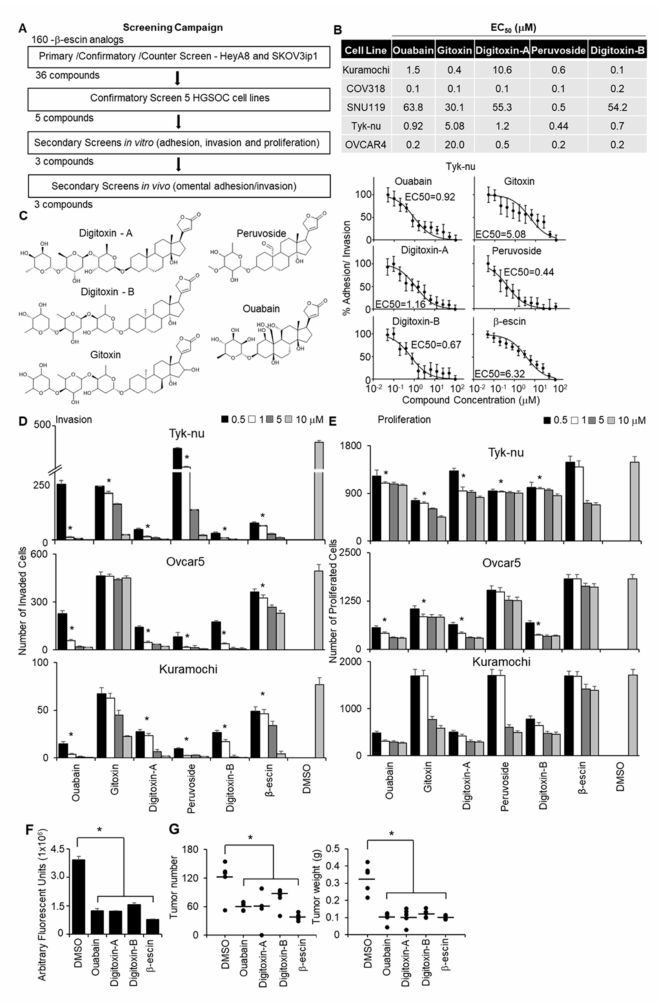
Figure 2. Quantitative high throughput screening with a 3D organotypic model to identify the compounds structurally similar to β -escin that inhibit OvCa metastasis. ( A ) An outline of the screening strategy and the number of active compounds after each assay are shown. ( B ) The half-maximal response values (EC 50 ) of each compound for their inhibitory effect on OvCa cell adhesion/invasion to the 3D organotypic model (16 h) are reported. Representative dose − response curves of Tyk-nu OvCa cell adhesion/invasion to the 3D organotypic model (16 h, mean ± standard deviation, n = 8). ( C ) Chemical structures of the active compounds. ( D , E ) In vivo secondary biological screens. Invasion and proliferation assays. The effect of β -escin sources at four doses were tested in three OvCa cell lines. ( D ) OvCa cancer invasion (24–48 h) was tested using a 96-well Boyden chamber lined with collagen type I as the ECM using the 3D organotypic culture. ( E ) OvCa cell proliferation (96 h) was tested in 384-well plates on the 3D organotypic culture. ( F , G ) In vivo biological screens. Adhesion/invasion and prevention metastasis assays were performed. The compounds were tested at a 5 µ mol/L dose or dimethyl sulfoxide (DMSO) solvent control (1 µ L) in cold phosphate-buffered saline (PBS; 500 µ L total). GFP-labeled ID8 p53-/- cells (5 million) were mixed with the indicated compound and injected into C57BL/6 mice. ( F ) In vivo adhesion/invasion assay. The mice were sacrificed at 16 h, and the fluorescence signal in the omentum was measured. ( G ) In vivo prevention metastasis assay. After the initial injection of cancer cells and drug (5 µ mol/L) or DMSO (1 µ L) in PBS (500 µ L total), the mice were interperitoneally injected with drug (1 mg/kg/day) or DMSO (1 µ L) in PBS (100 µ L total) on days 2 and 4. Forty-five days post cancer cell injection, the weight and number of tumors were determined. Mean ± standard deviation. *, p < 0.05, n = 5–8. DMSO— dimethyl